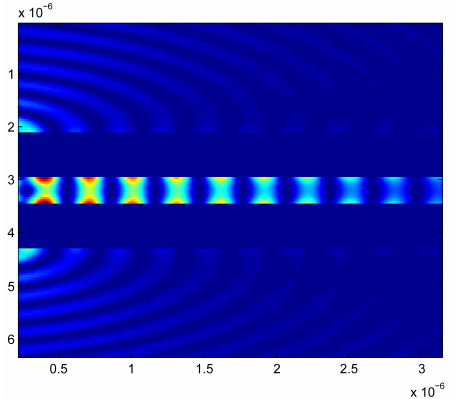
Figure 8: Convergence history of GMRES for the plas- monic waveguide problem.